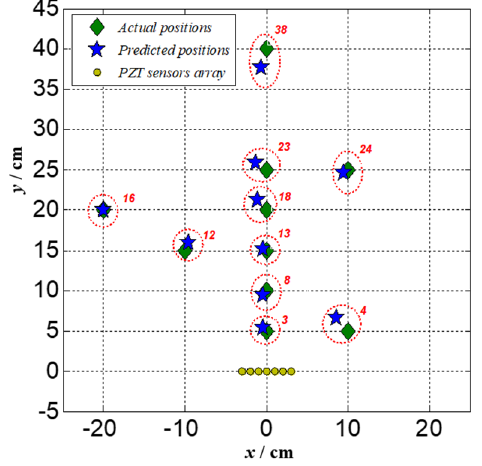
Figure 11. Impact location graphical results in Cartesian coordinates.